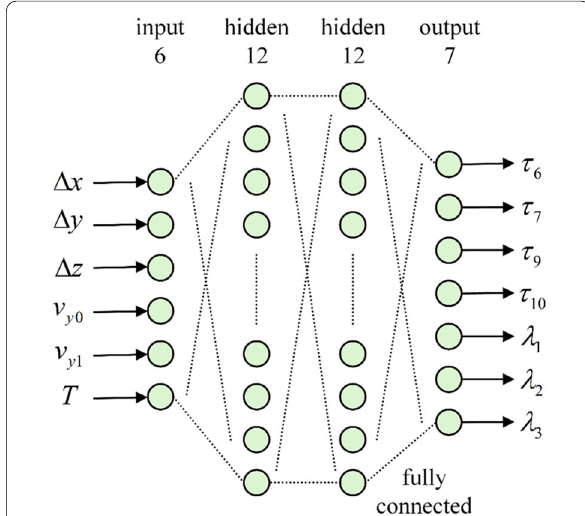
Figure 5 Neural network structure of trajectory smoothness